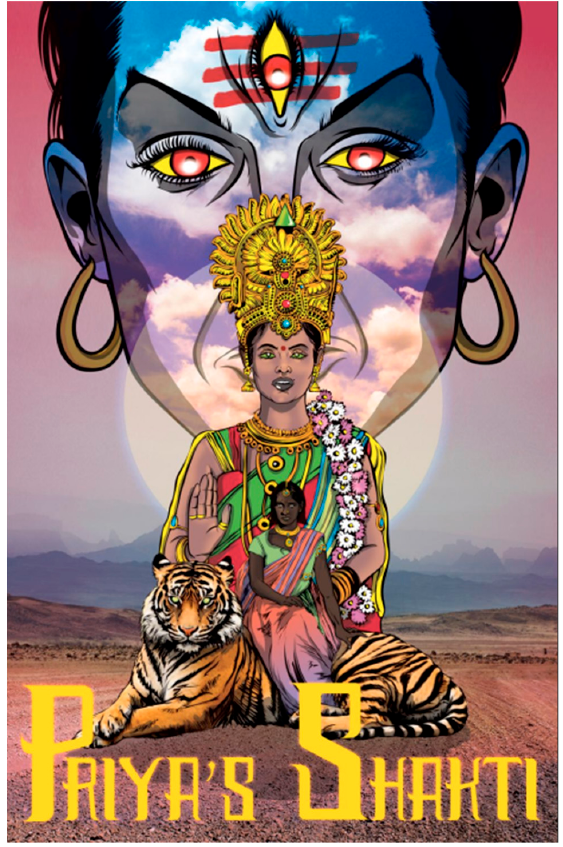
Figure 2. The cover of the Priya’s Shakti digital comic book depicting Priya seated on a tiger with the goddess Parvati in the background. Image Courtesy: Ram Devineni.